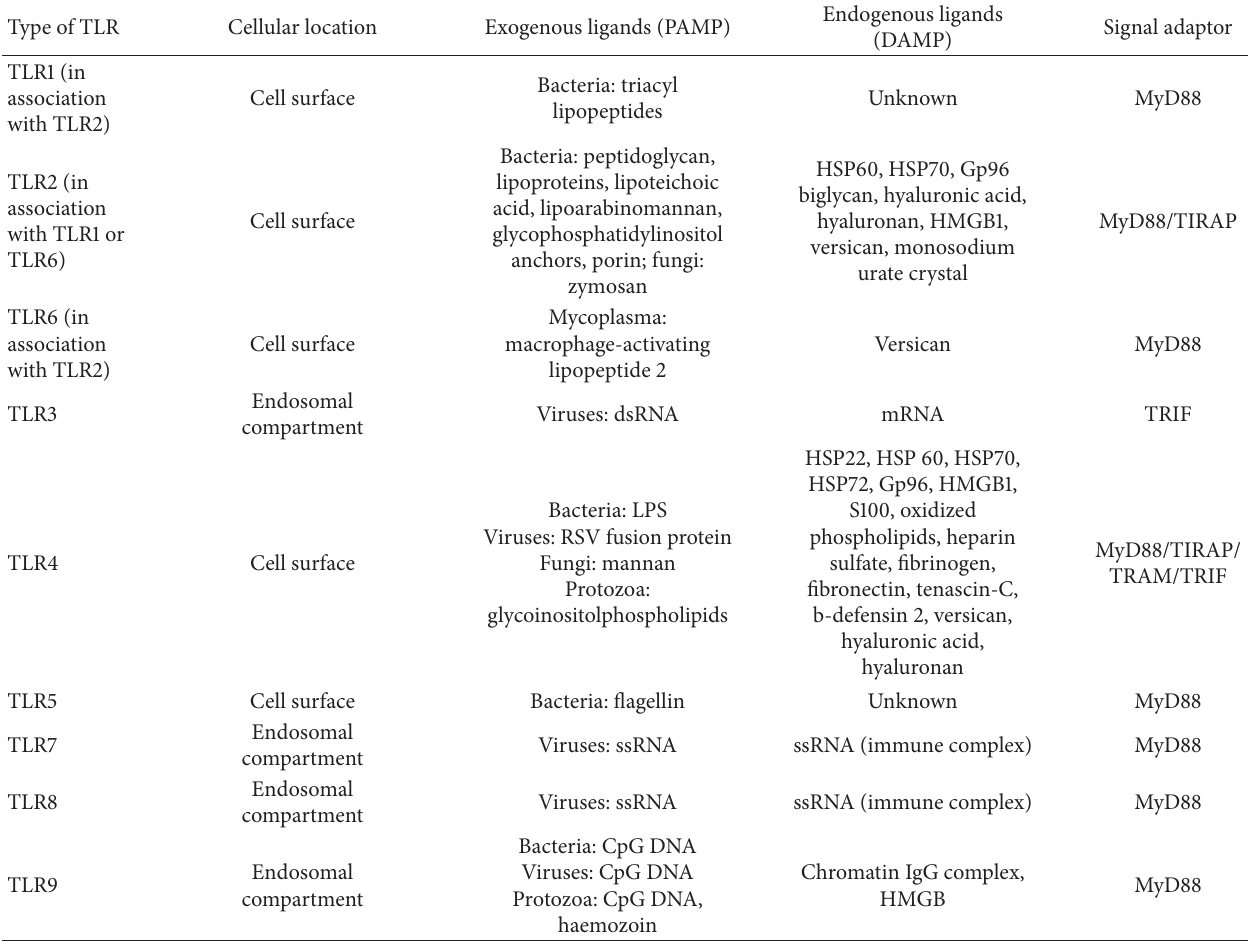
Table 1: TLRs, their cellular location, ligand recognitions, and adaptor